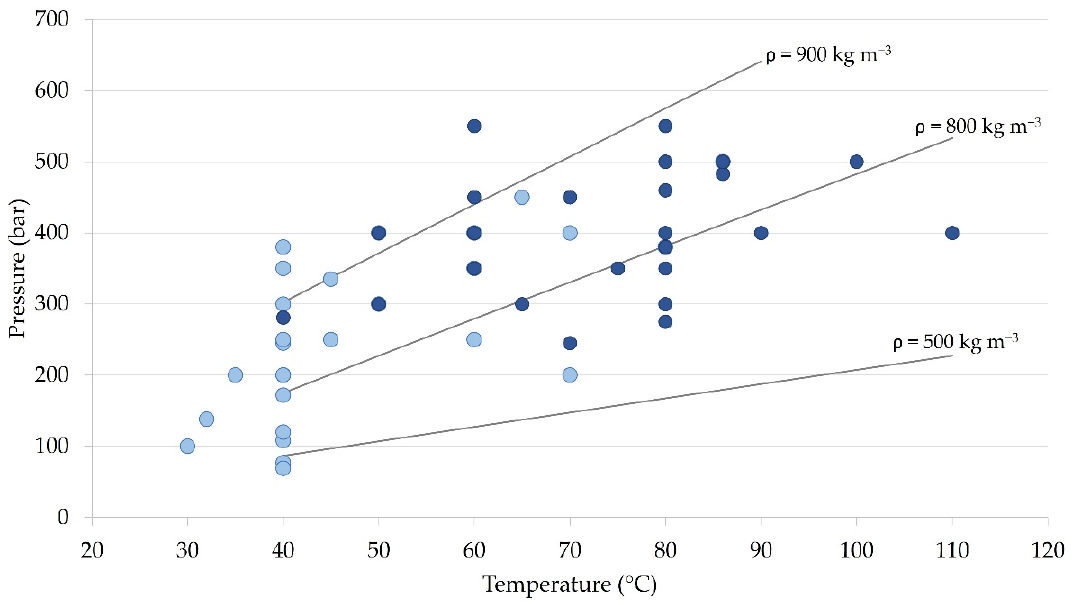
Figure 5. Operating conditions (pressure and temperature) of the studies listed in Table 1 using SC-CO 2 . Light blue and dark blue dots represent the regions of lower and higher CO 2 densities in each work, respectively. Lines of CO 2 constant density (calculated with PC-SAFT equation of state) are indicated in gray.